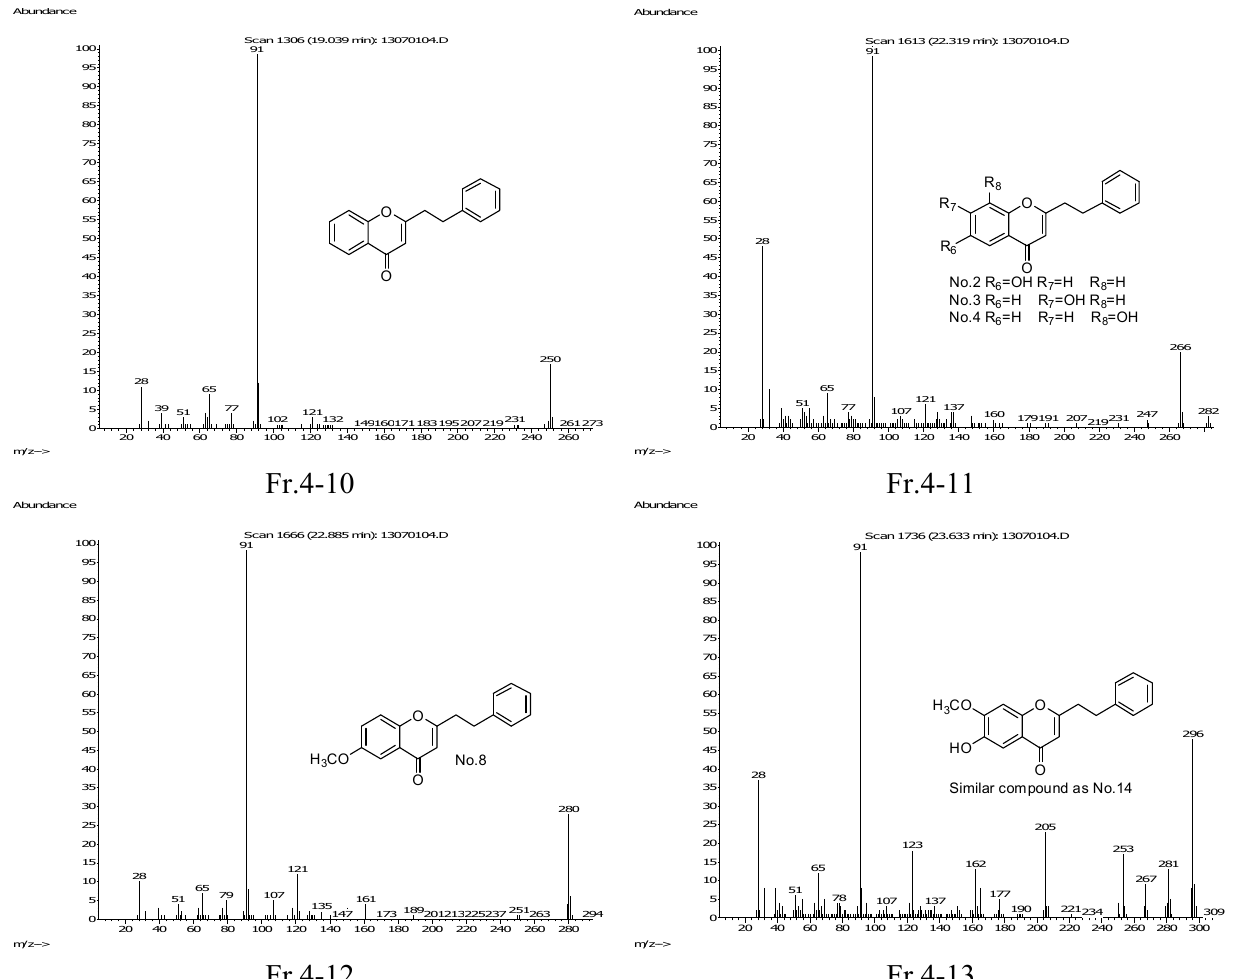
Figure 4. MS spectra and structures characterization of 2-(2-phenylethyl)chromones of fraction 4 of agarwood